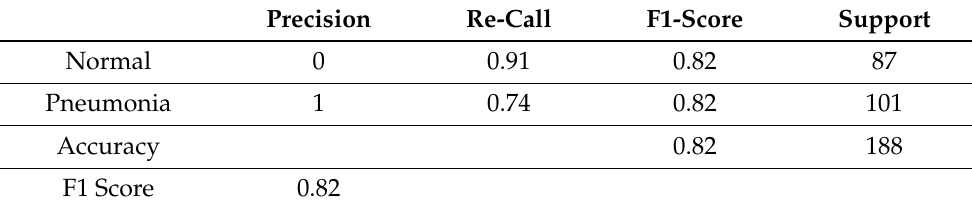
Table 5. Result analysis of the ResNet model.